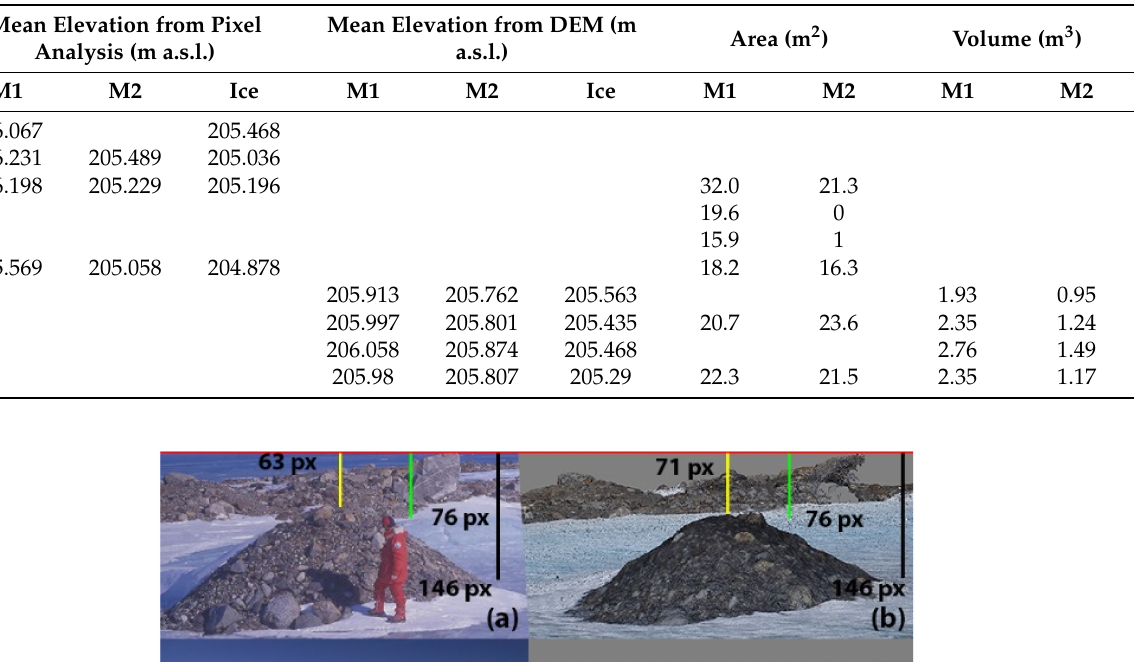
Table 2. Multidimensional differences of the frost blisters dimensions and the ice level during the study period. The pixel analysis shows the reconstructed elevations for the period 1996–2014 graphically shown in Figure 4. The DEMs shows the real elevations for the period 2017–2019. Area and volume show the dimensions of M1 and M2 calculated from the aerial images, orthophotos and DEMs in different years. “Ice” from 2017 to 2019 refers to the mean change of the internal ice area near the frost blisters.